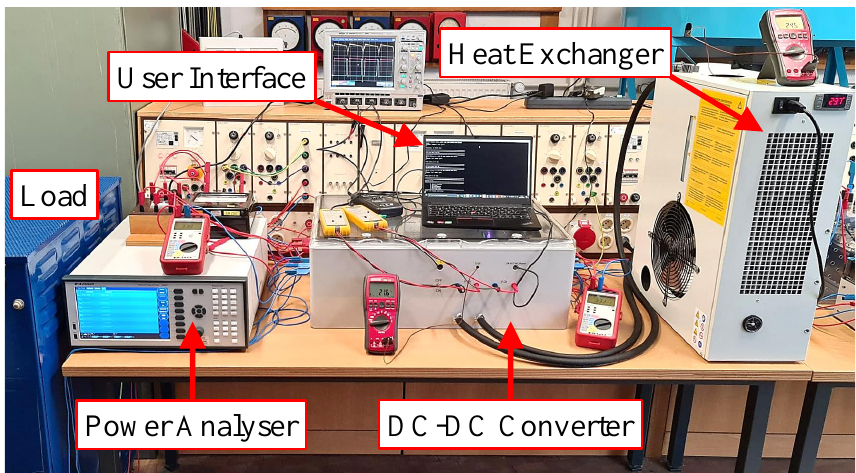
Figure 8. Full experimental setup; bidirectional cascaded buck and boost converter.